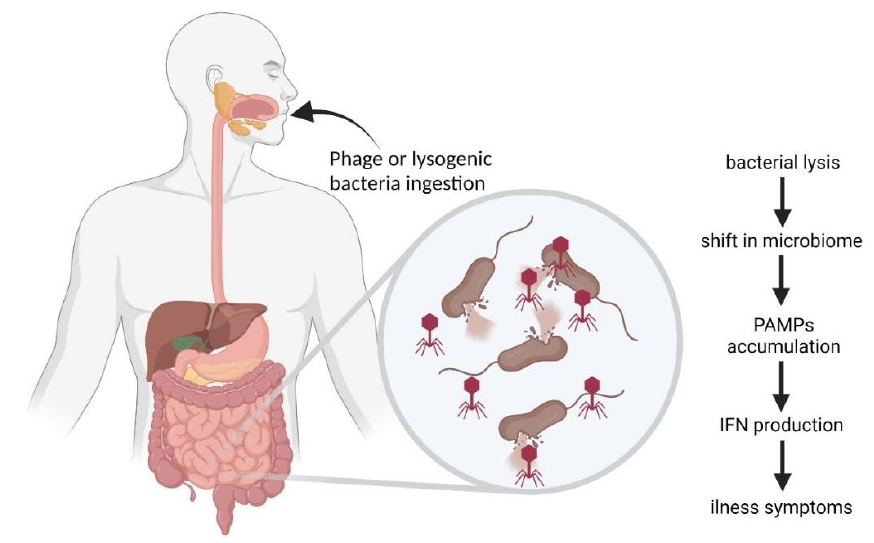
Figure 5. Scheme of “phage infection” as proposed by Tetz and Tetz [133] (modified).